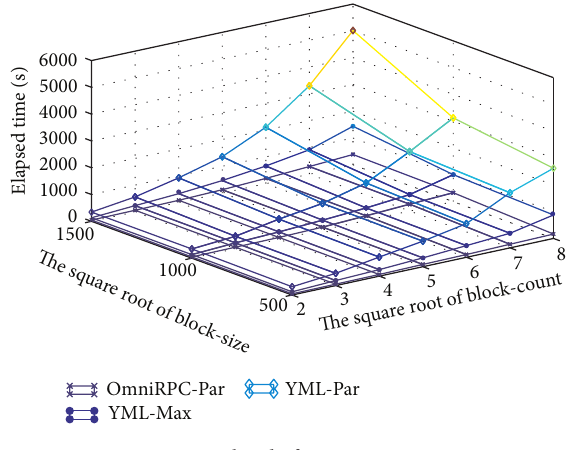
Figure 5: Overhead of YML on OmniRPC.